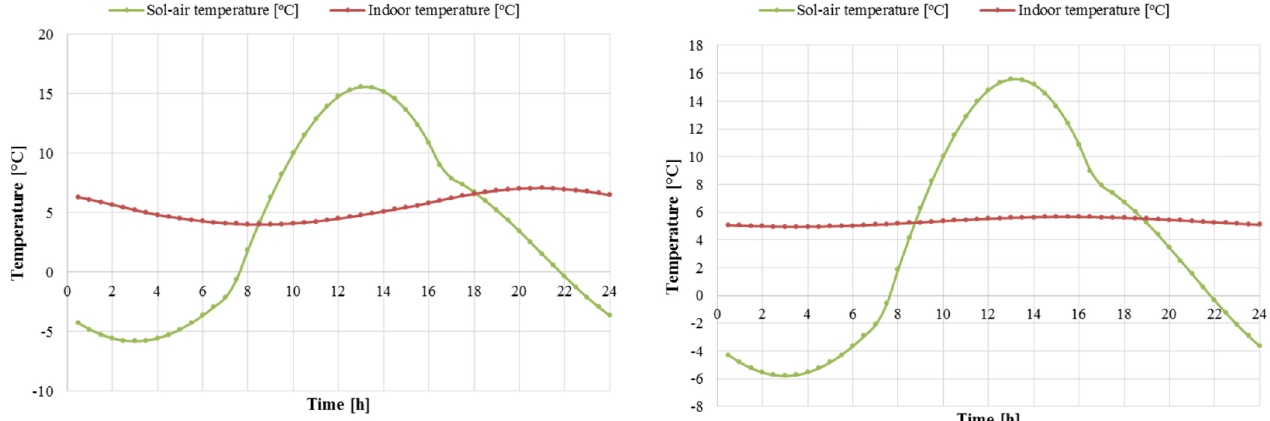
Fig. 10. Variation of the indoor temperature for walls taking into account the solar radiation. On the left with inside insulation. On the right with outside